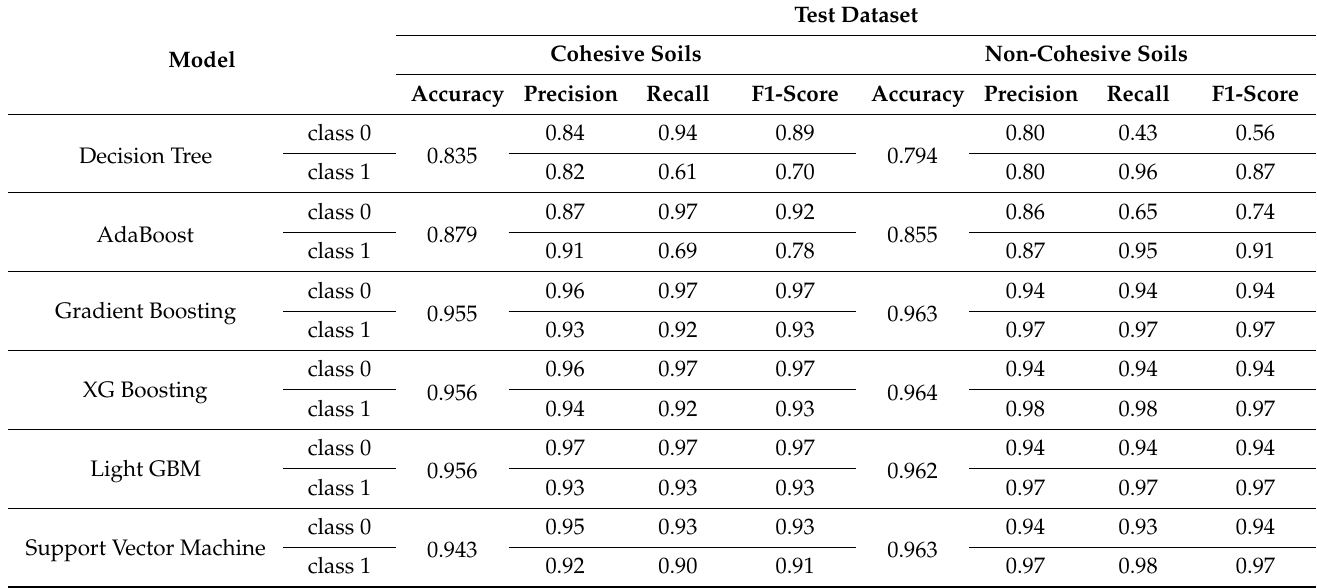
Table 11. Evaluation of classification performance (step 2) for EPB TBM datasets.